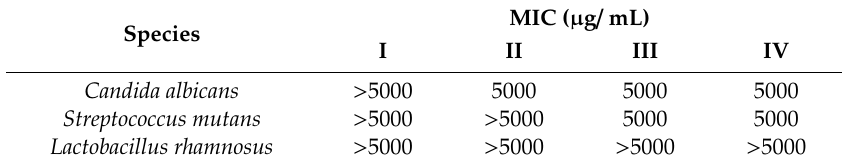
Table 1. Values of Minimal Inhibitory Concentration (MIC) of nHAp for analyzed strains. MIC ( µ g / mL) Species I II III IV Candida albicans > 5000 5000 5000 5000 Streptococcus mutans > 5000 > 5000 5000 5000 > 5000 > 5000 > 5000 >